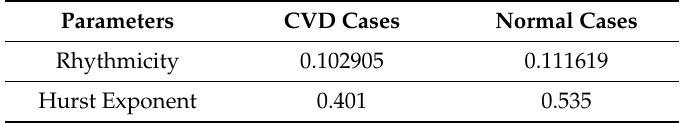
Table 6. Rhythmicity and Hurst exponent analysis on fuzzy modeled